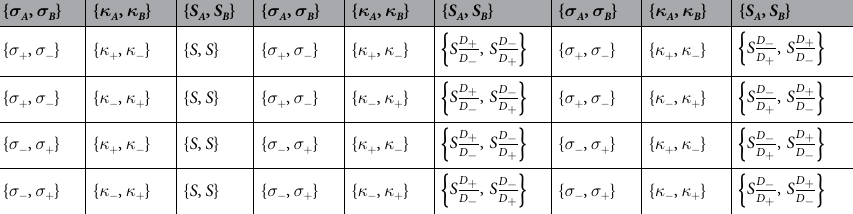
Table 1. A list of all possible choices for the material properties of each pair of layers comprising the bilayer laminate